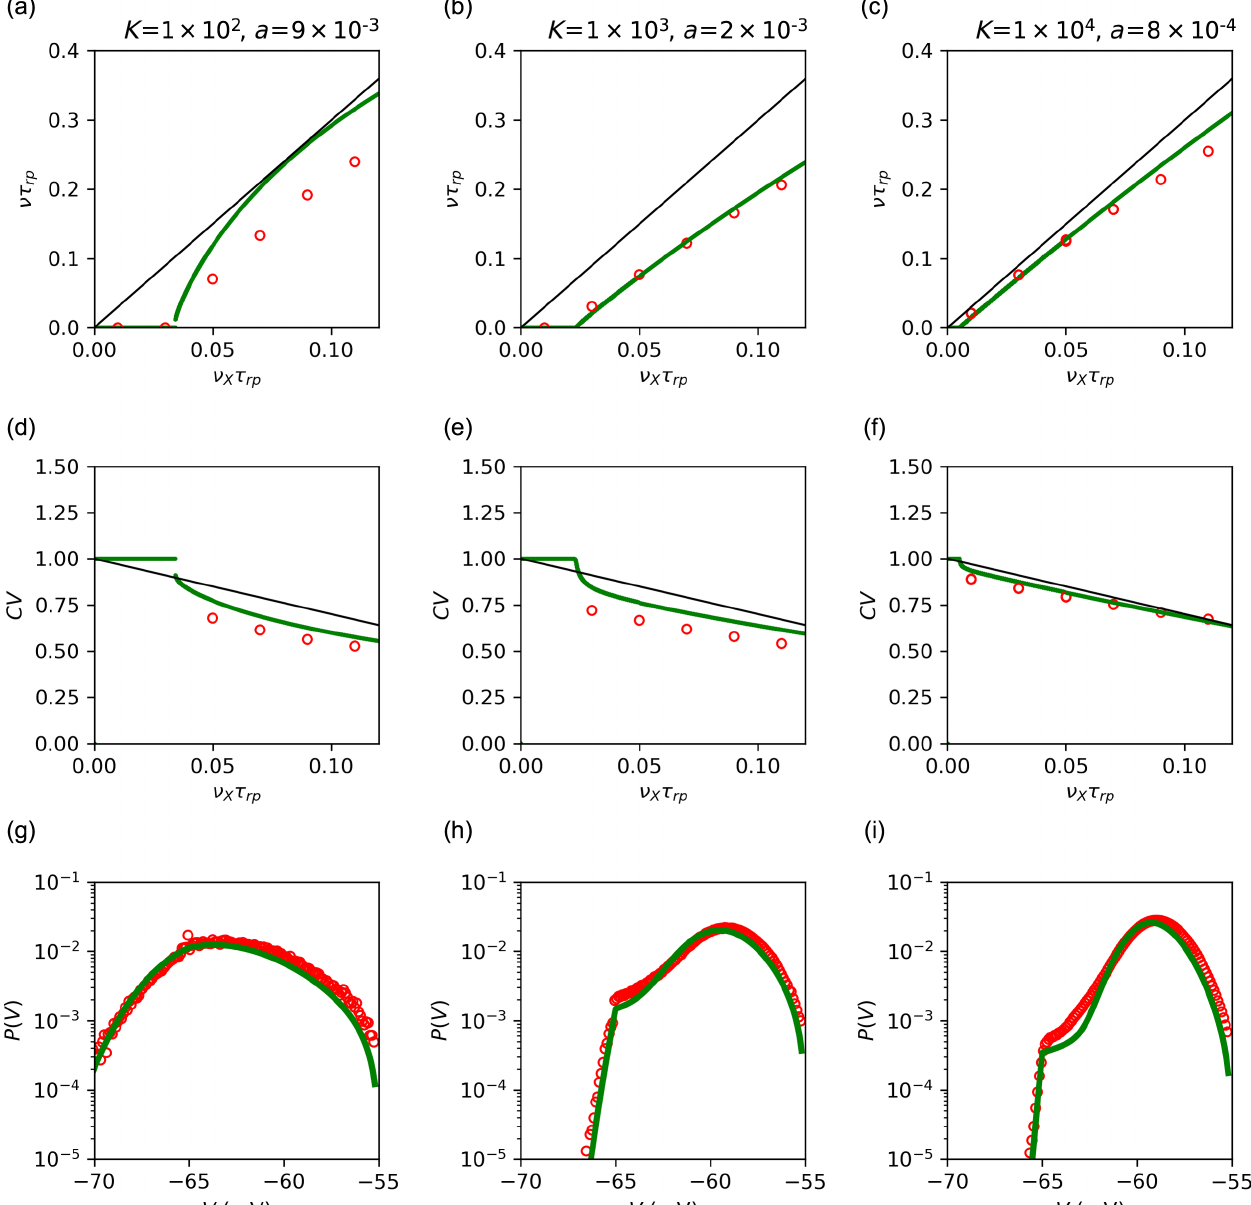
FIG. 14. Comparison of mean field theory and numerical simulations. Network transfer function (first row), CV of ISI distribution (second row), and probability distribution of the membrane potential at ν prediction (green), results from numerical simulations (red), and the value expected in the strong-coupling limit (black). Different columns correspond to different values of K and a which are scaled according to Eq. (D10). The agreement between network simulations (red) and mean field predictions (green) improves as a decreases, as expected, since we use the diffusion approximation to derive the results. Simulation parameters are g ¼ 20 and N